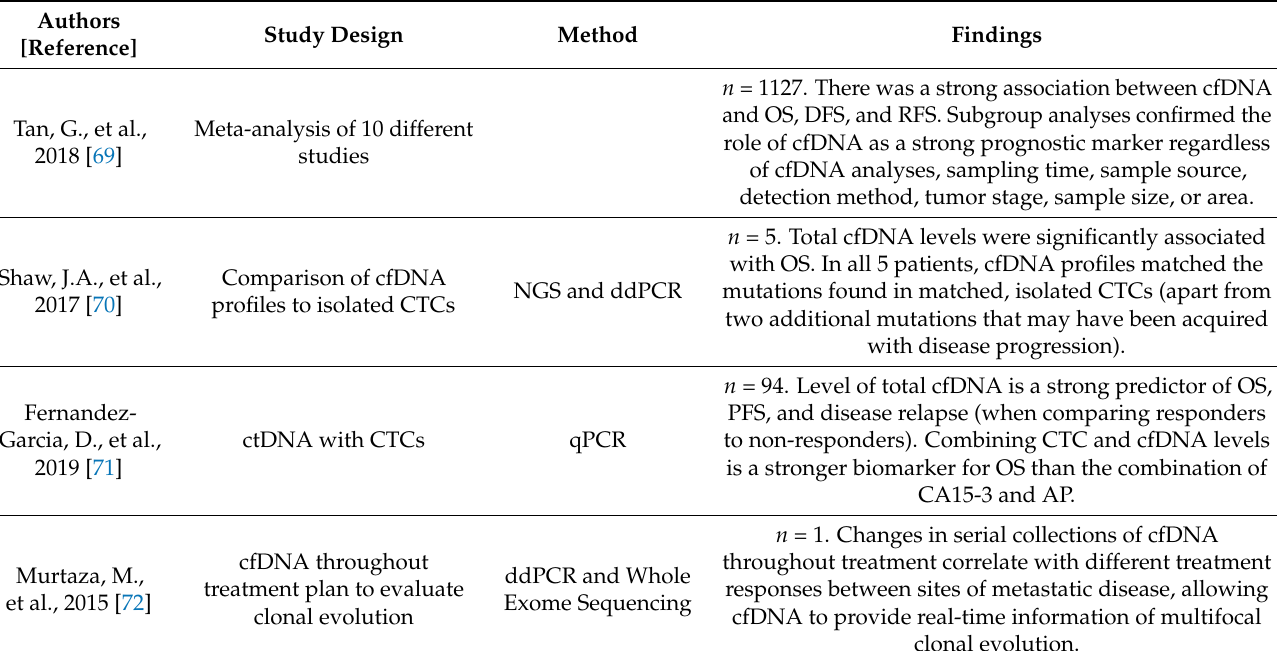
Table 4. ctDNA in metastatic breast